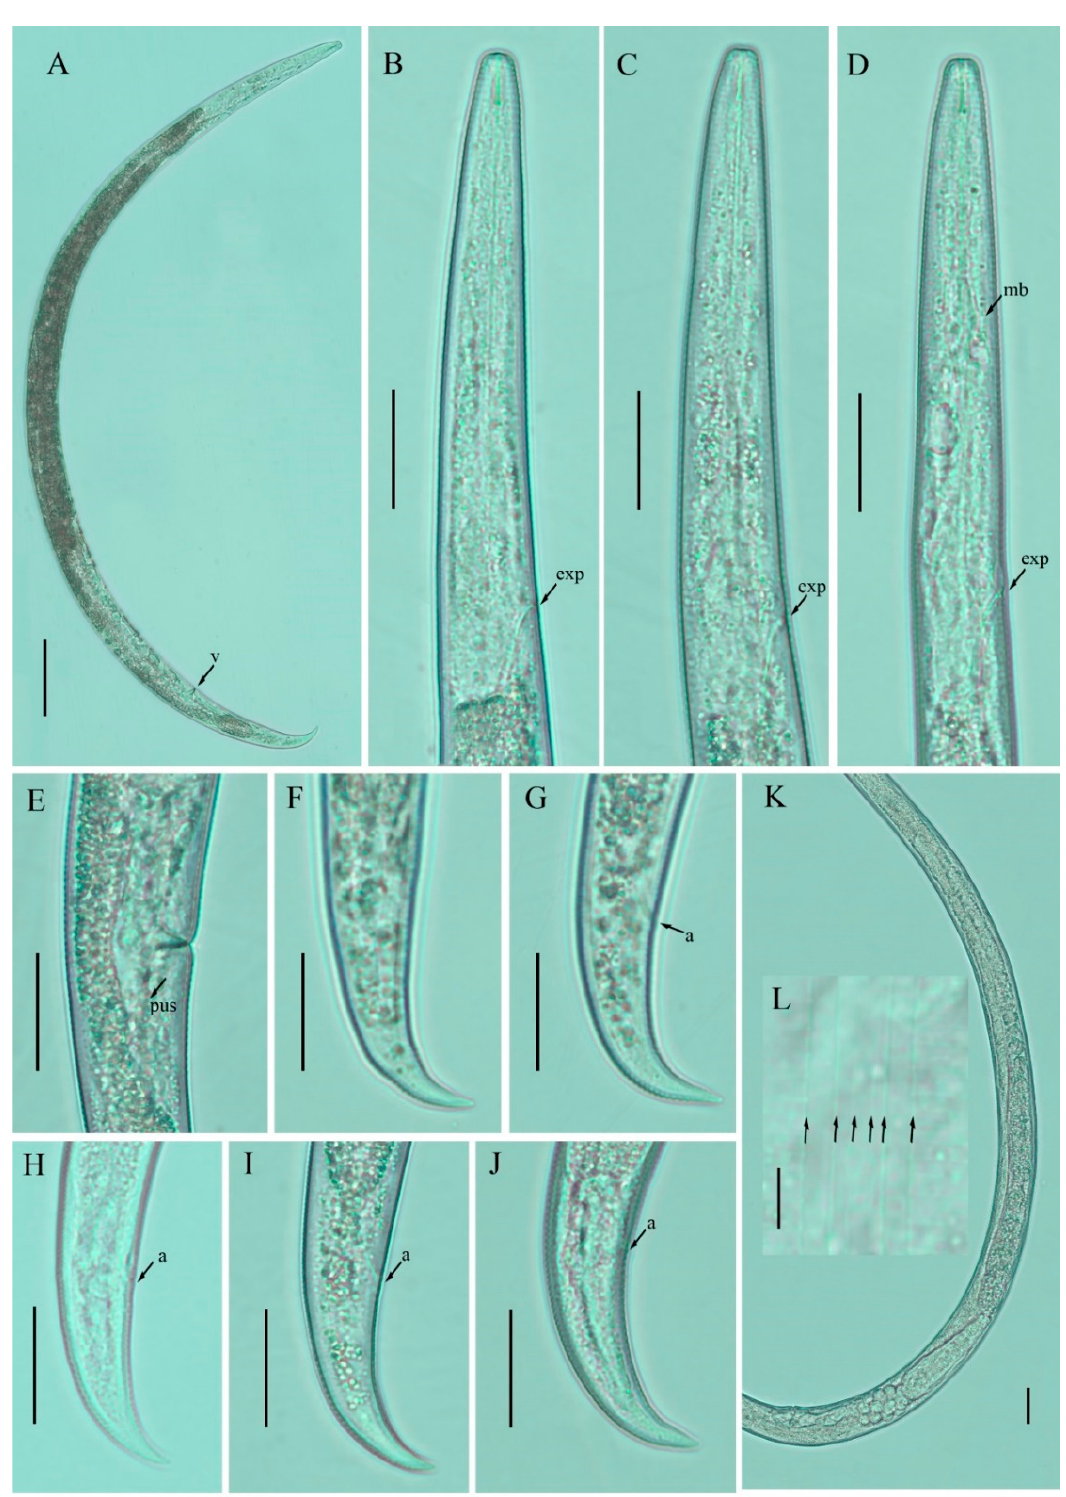
Figure 2. Photomicrographs of Nothotylenchus similis female. ( A ) Entire body; ( B – D ) pharyngeal re- gions; ( E ) vulval region; ( F – J ) tail regions; ( K ) posterior body to tail terminus; ( L ) lateral lines (arrow- heads indicating the number of lines). Scale bars: ( A ) 50 μ m; ( B – K ) 20 μ m; ( L ) 5 μ m. Arrowheads: (a) anus; (exp) excretory pore; (mb) median bulb; (pus) post-vulval uterine sac; (v) vulva.